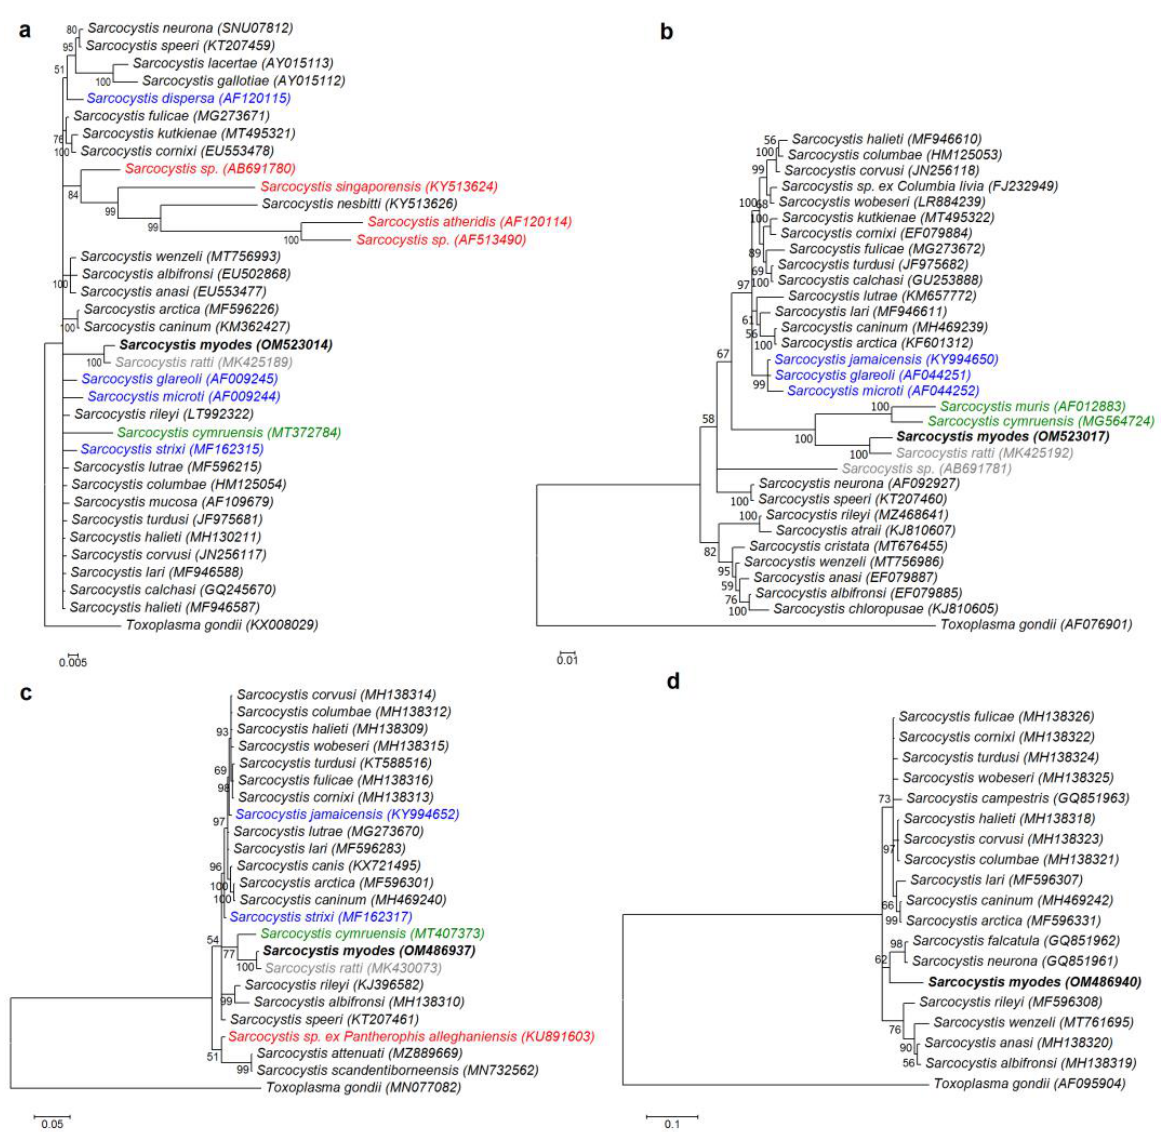
Figure 3. Phylogenetic trees of selected Sarcocystis species. The trees constructed based on ( a ) 18S rDNA sequences, ( b ) 28S rDNA sequences, ( c ) cox1 sequences, and ( d ) rpoB sequences. The posterior probability support values are indicated next to branches. All color-coded Sarcocystis species are found in muscles of rodents. Sarcocystis species that are known to be distributed by birds are marked in blue, species that are distributed by snakes are marked in red, those transmitted by predatory mammals are in green, and species whose definitive hosts are not yet known are in a grey color.